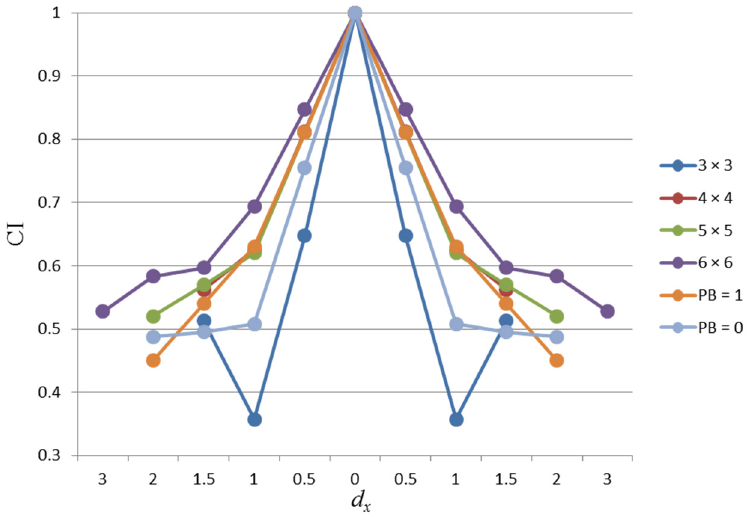
Figure 8. Comparison of our schemes with the misalignment-tolerant visual secret sharing (MTVSS) scheme for shifting the same pixels. CI, correctness index.